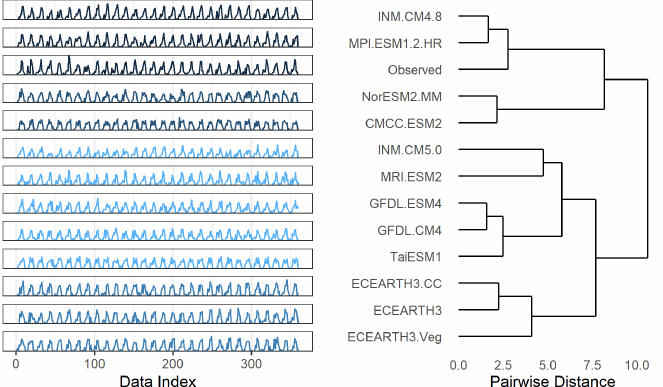
Figure 3. Clusters for the monthly precipitation series for the observed and climate model series (the left figure shows the cluster separation with blue color contrast, and the right figure shows the clustering of climate models and observed data in terms of time series similarities based on seasonal